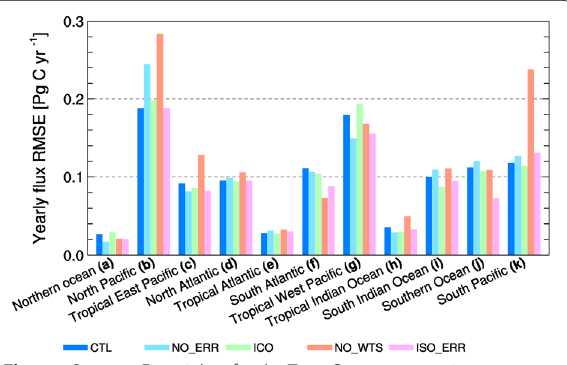
Fig. 10 Root-mean-square errors of the yearly fluxes against the true fluxes for the TransCom terrestrial regions. Results of the CTL and the other four sensitivity tests are illustrated here